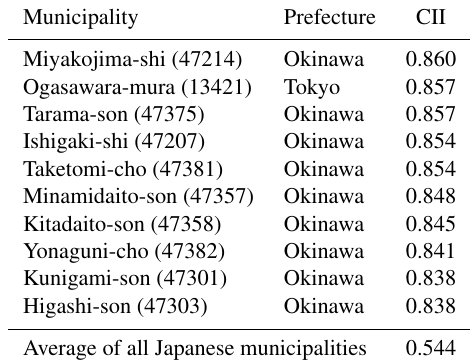
Table 4. Same as Table 2 but for the average CII for the 30 low-CII